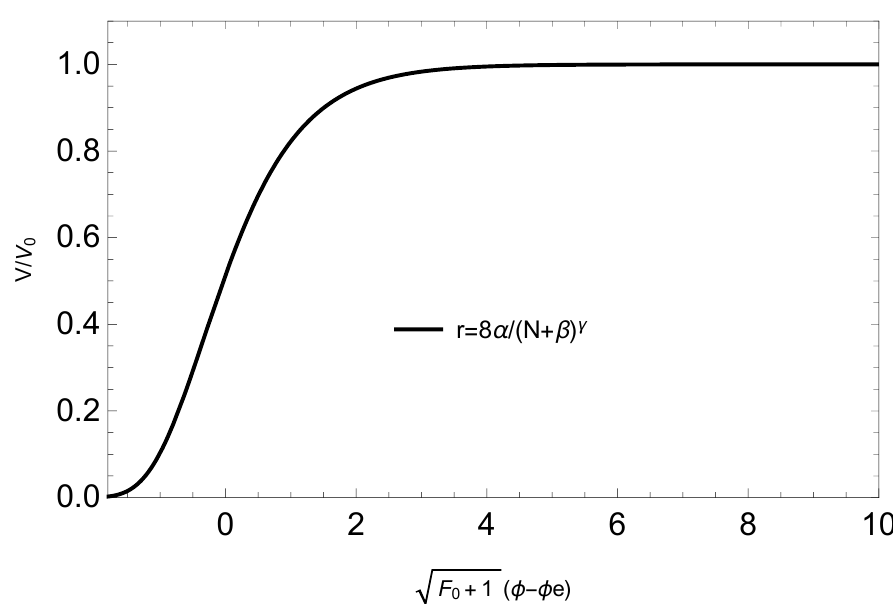
Figure 2. The reconstructed potentials are normalized with V 0 from Equation (30), and the inflaton √ F 0 + 1. We choose the value of φ 0 that could make φ e = 0. field is normalized with 1/ 4.